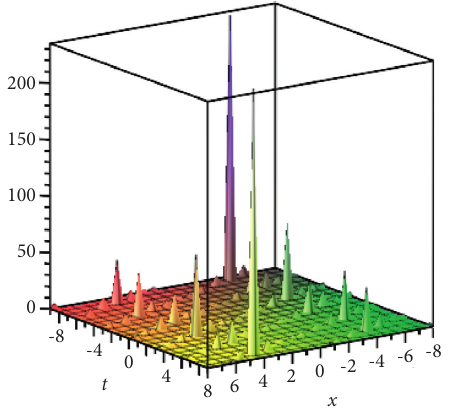
( x, t )| when β � 0 . 05 , 5